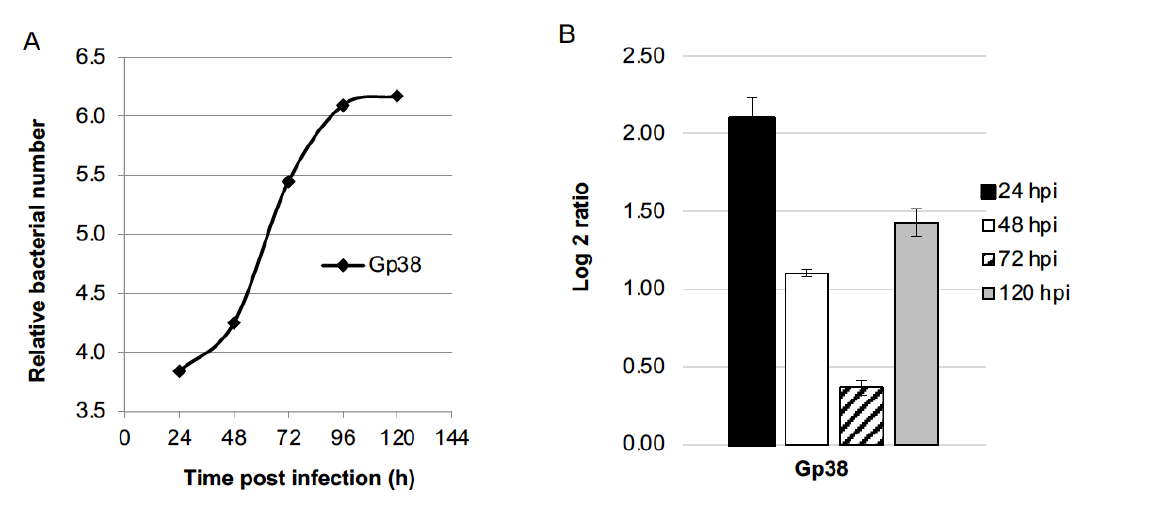
Figure 1. Temporal expression of the (ERGA_CDS_01230) ape gene in E. ruminantium determined by qRTPCR. (A) E. ruminantium sigmoïdal growth curve was determined by qPCR targeting pCS20 region and represented as relative bacterial number along the developmental cycle. (B) Transcript levels were determined from 24, 48, 72 and 120 hpi by qRTPCR targeting ERGA_CDS_01230 gene. Levels were normalized by the quantity of bacteria measured by qPCR Sol1 and the ratio was compared to 96 hpi, allowing fold-change (FC) determination, expressed as log 2. Values at each time point are the means +/- standard deviations for 2 biological replicates. Gp38 is for E. ruminantium Gardel strain, passage #38 (virulent